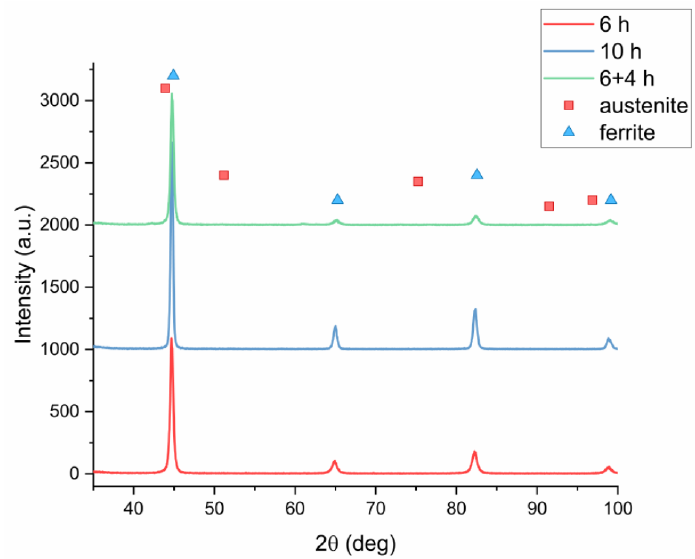
Figure 8. XRD analysis of the samples after different heat treatments: quenched and tempered at 590 °C for 6 h (red line); quenched and tempered at 590 °C for 10 h (blue line); quenched and tempered at 590 °C 6 h + 590 °C 4 h (green line).